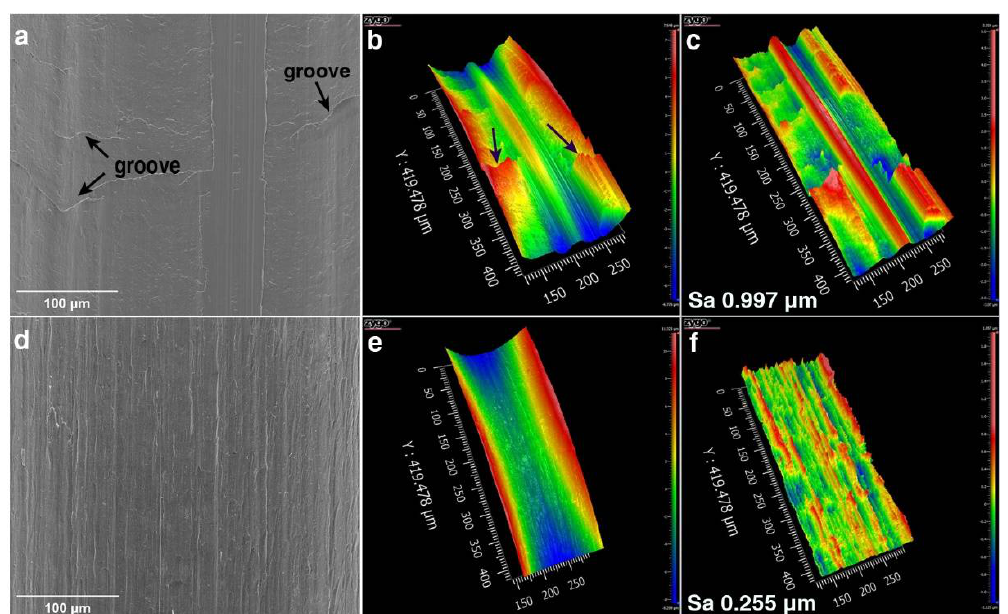
Figure 2. Surface morphology of the thread. ( a ) SEM image of the ‘as-received’ bolt at 500×. ( b ) The 3D profile of the as received bolt. ( c ) Flattened image of ( b ). ( d ) SEM image of the rolled bolt at 500×. ( e ) The 3D profile of the rolled bolt. ( f ) Flattened image of ( e ).